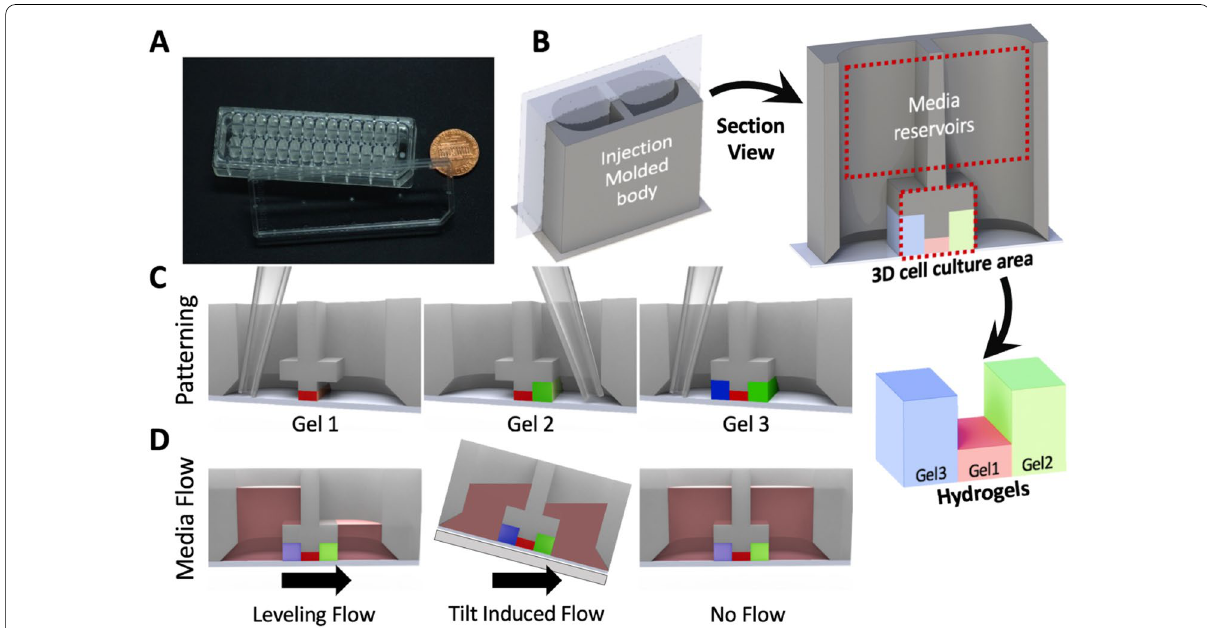
Fig. 1 Overview of chip design and hydrogel/media patterning. A A photograph of the MV‑IMPACT chip body with top lid. B Rendering of a single unit well with cross section view of the entire well and patterned gel. C Illustration of edge guided sequential patterning within a cross section view of a unit well. D Different methods of inducing flow conditions. From left to right, levelling flow utilizes differences in media volumes within the two reservoirs to induce flow through the patterned gels via equilibration. Tilt induced flow elevates one reservoir over another to facilitate flow. Static flow conditions can be induced by adding the same volume of media in both